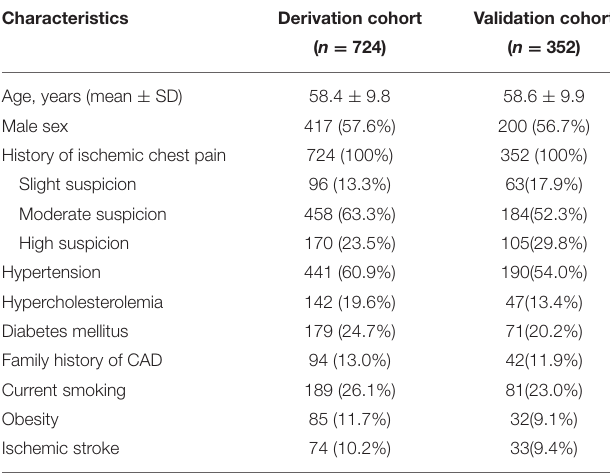
TABLE 1 | Baseline characteristics of the derivation and validation cohort*.